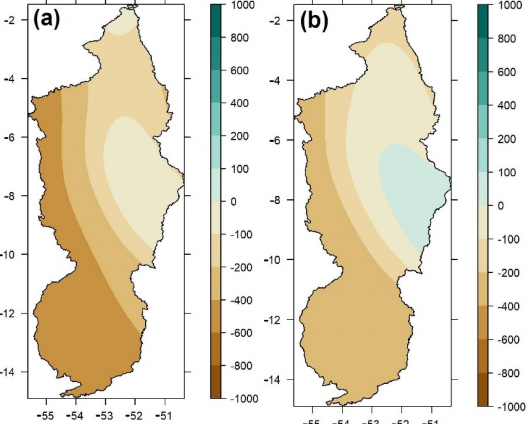
Figure 7. Projected annual deviation in the precipitation over the XRB, in mm/period, for the 2021–2050 period, according to the RCP 4.5 ( a ) and RCP 8.5 ( b )